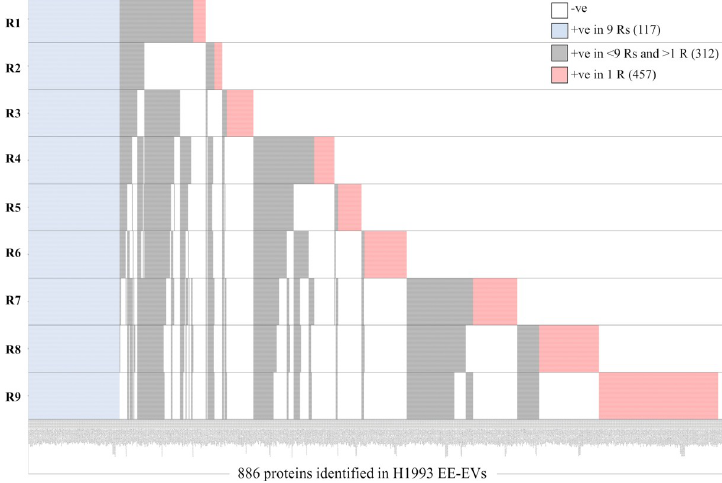
Fig 4. Heatmap showing number of samples in which each of the total 886 proteins was identified in H1993 exosomes. Proteins common to all nine replicates are shown in blue (117). Proteins present in > 1 replicate and < 9 replicates are shown in grey (312) and proteins present only in 1 replicate are shown in red (457).